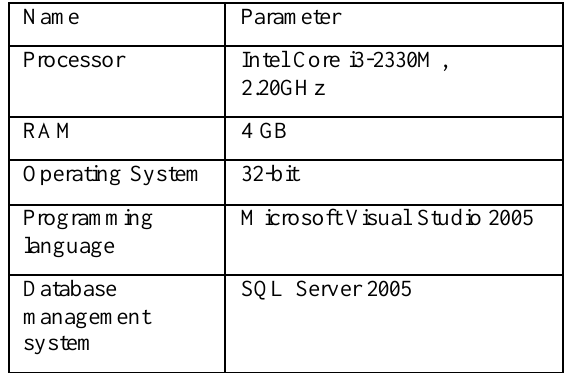
Table 4. Experimental environments